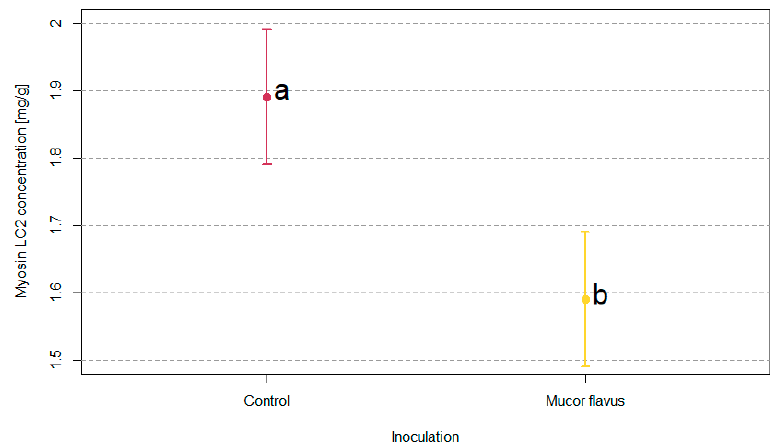
Figure 4. Differences in proteolysis of myosin LC2 chain. Average concentrations with standard deviation bars are shown; a, b—means marked with different letters differ significantly at p < 0.05.